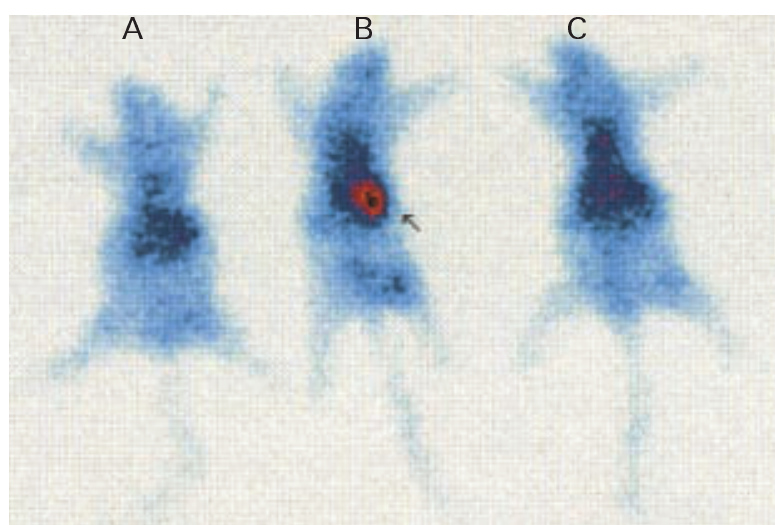
Figure 4 - Images of nude mice bearing tumors of 1 cm in their largest diameter treated with 99m Tc-labeled mAbs 24 h after injection. Animals: A) isotype control 8F9 mAb in a CEA- positive tumor (LS-174T); B) anti-CEA 6D1.1 mAb in a CEA-positive tumor (LS-174T) indi- cated by the arrow, and C) anti-CEA 6D1.1 mAb in a CEA-negative tumor